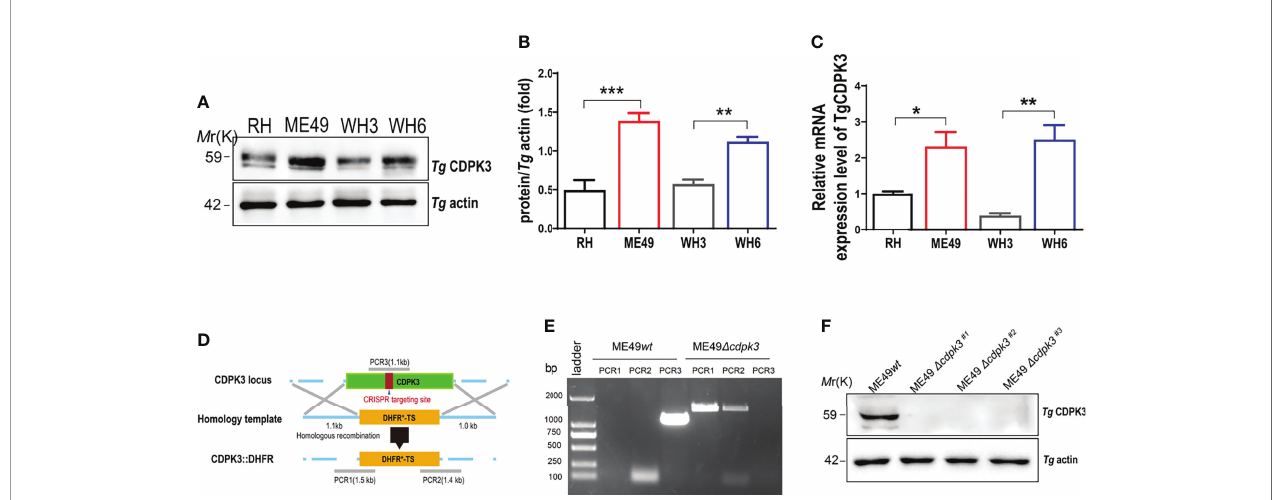
FIGURE 1 | Construction of the ME49 D cdpk3 strain of Toxoplasma gondii by using CRISPR-Cas9 technology. (A, B) The expression levels of CDPK3 in four strains of RH, ME49, WH3, and WH6 were detected by Western blotting. T. gondii actin was used as a loading control. (C) The RNA expression levels of CDPK3 in four strains of RH, ME49, WH3, and WH6 were analyzed by quantitative real-time PCR (RT-qPCR). (D) Schematic of CRISPR/CAS9 strategy for replacing CDPK3 with pyrimethamine-resistant DHFR (DHFR*) and PCR identi fi cation of single clone. (E) PCR identi fi cation of ME49 D cdpk3 T. gondii strain. PCR1 and PCR2 check for 5 ’ and 3 ’ integration of the selection marker, while PCR3 checks for successful deletion of the CDPK3 gene. Wild-type ME49 (ME49 wt ) strain was used as a control. (F) Western blotting for detection of CDPK3 expression in ME49 wt and ME49 D cdpk3 . T. gondii actin antibody was used as a loading control. Data are mean ±